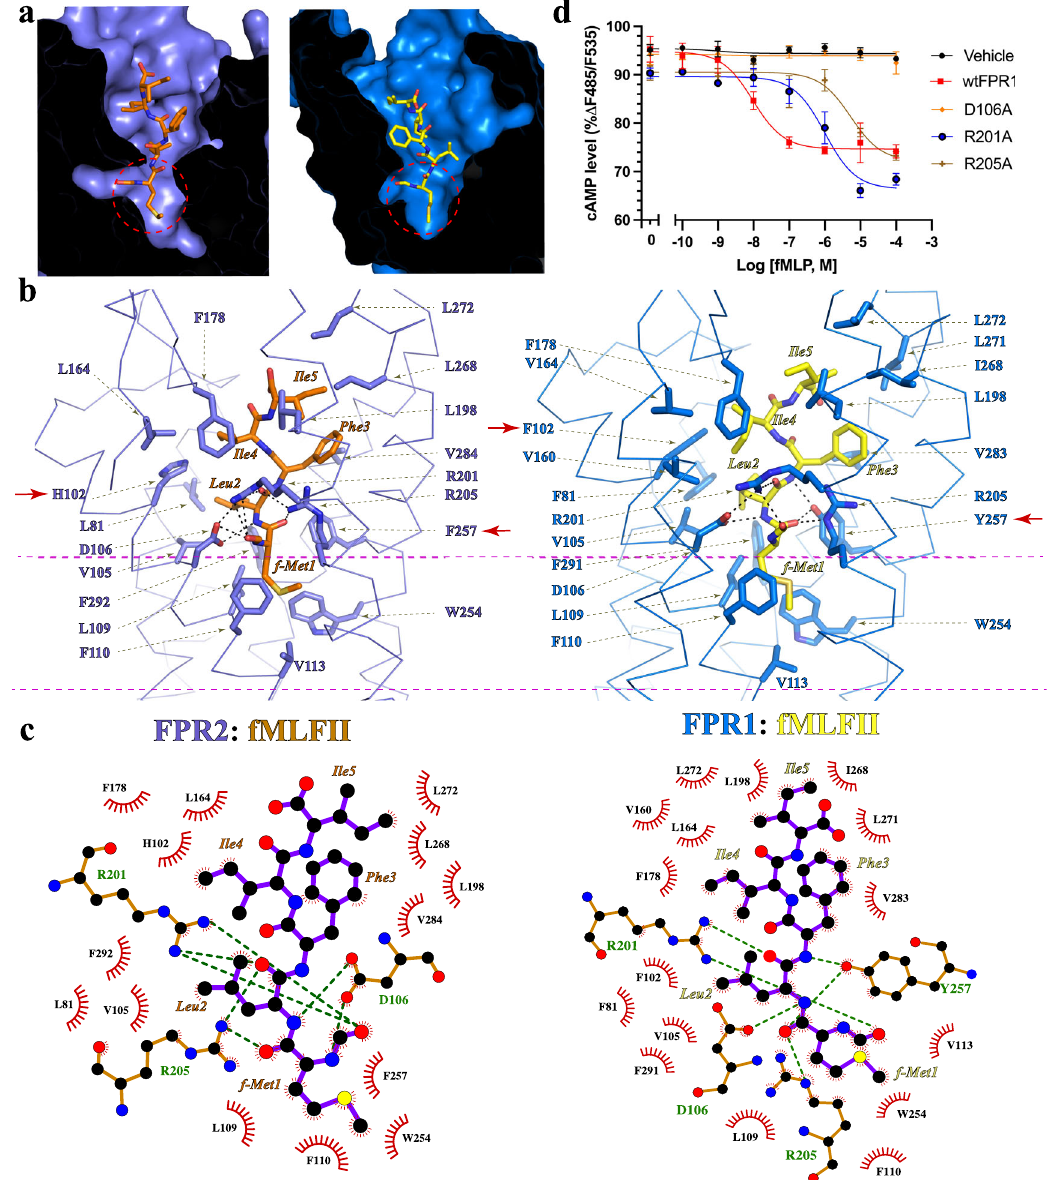
Fig. 3 Binding of fMLFII to FPR1 and FPR2. a Overall binding modes of fMLFII in FPR1 (blue) and FPR2 (slate). The N-terminal formyl methionine residue of fMLFII is circled. b Details of binding pockets of fMLFII in FPR2 (left) and FPR1 (right). Red arrows point to non-conserved residues H102 and F257 in FPR2 and F102 and Y257 in FPR1. Polar interactions are shown as black dashed lines. The activation chamber is shown between the two purple dashed lines. c Ligplot schematic representation of fMLFII interactions with FPR2 (left) and FPR2 (right). The carbon, nitrogen, oxygen, and sulfur atoms are colored in black, blue, red, and yellow, respectively. Residues in FPR1 and FPR2 that form polar interactions with fMLFII are shown with green labels. Polar interactions are shown as green dashed lines. The ligand is shown as purple sticks. d Dose-dependent action of fMLFII on wide type FPR1 (wtFPR1) and mutants. Agonist-induced FPR1 signaling was measured by cAMP accumulation assay. Each data point represents mean ± S.D. Three independent assays were performed. Source data are provided as a Source Data fi